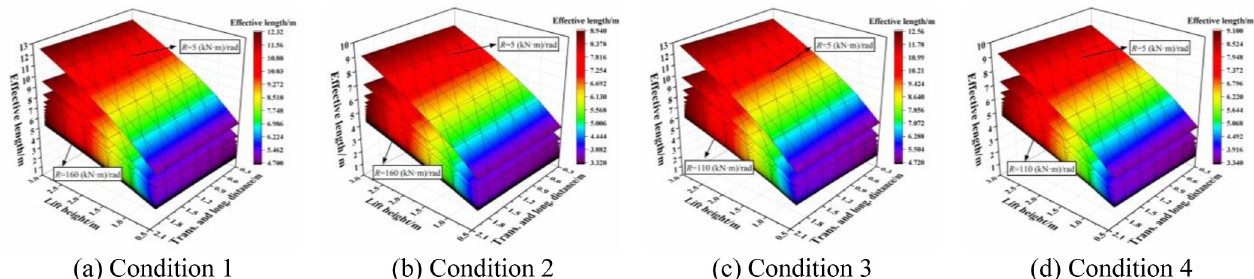
Fig 20. Value of the effective length under different conditions. (a) Condition 1. (b) Condition 2. (c) Condition 3. (d) Condition 4.